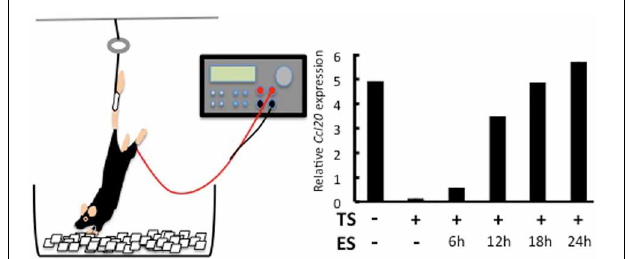
FIGURE 2 | Effects of regional neural activation on the invasion of Th17 cells into the CNS. Tail suspension and electric stimulation of the soleus muscles (left) . Tail suspension (TS) reduces CCL20 expression in the L5 dorsal vessel. Electric stimulations (ES) to the soleus muscles of TS mice restore the chemokine expression in a time-dependent manner (right) . See Arima et al. (2012) for the original